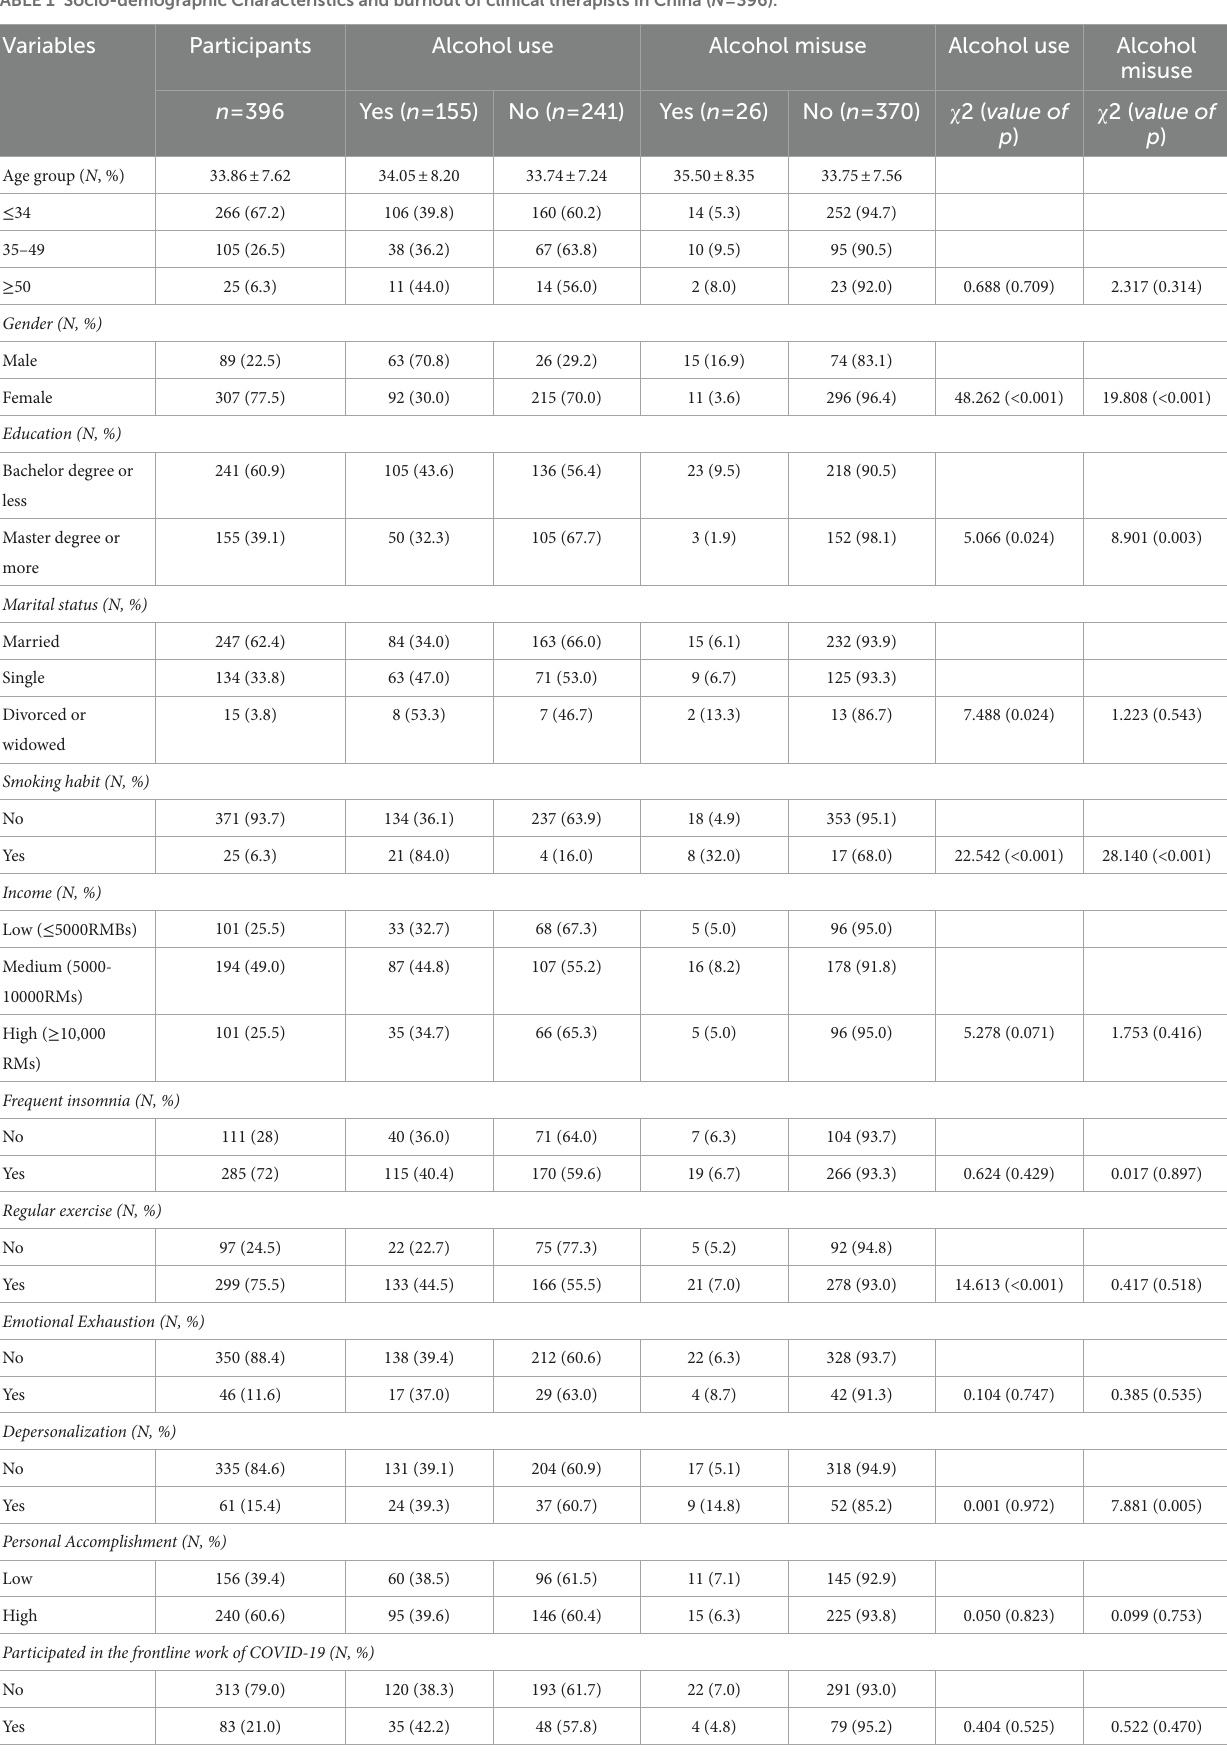
TABLE 1 Socio-demographic Characteristics and burnout of clinical therapists in China ( N = 396). Variables